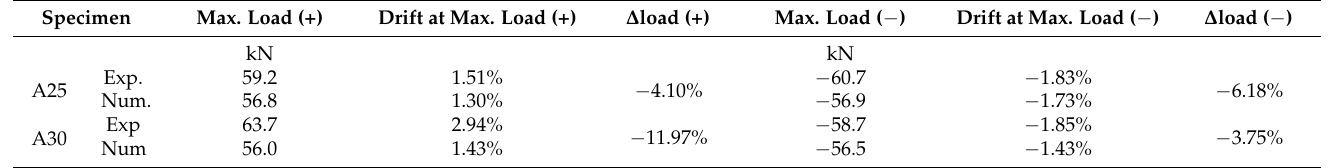
Table 7. Main results of un-corroded specimens, experimental vs. numerical.